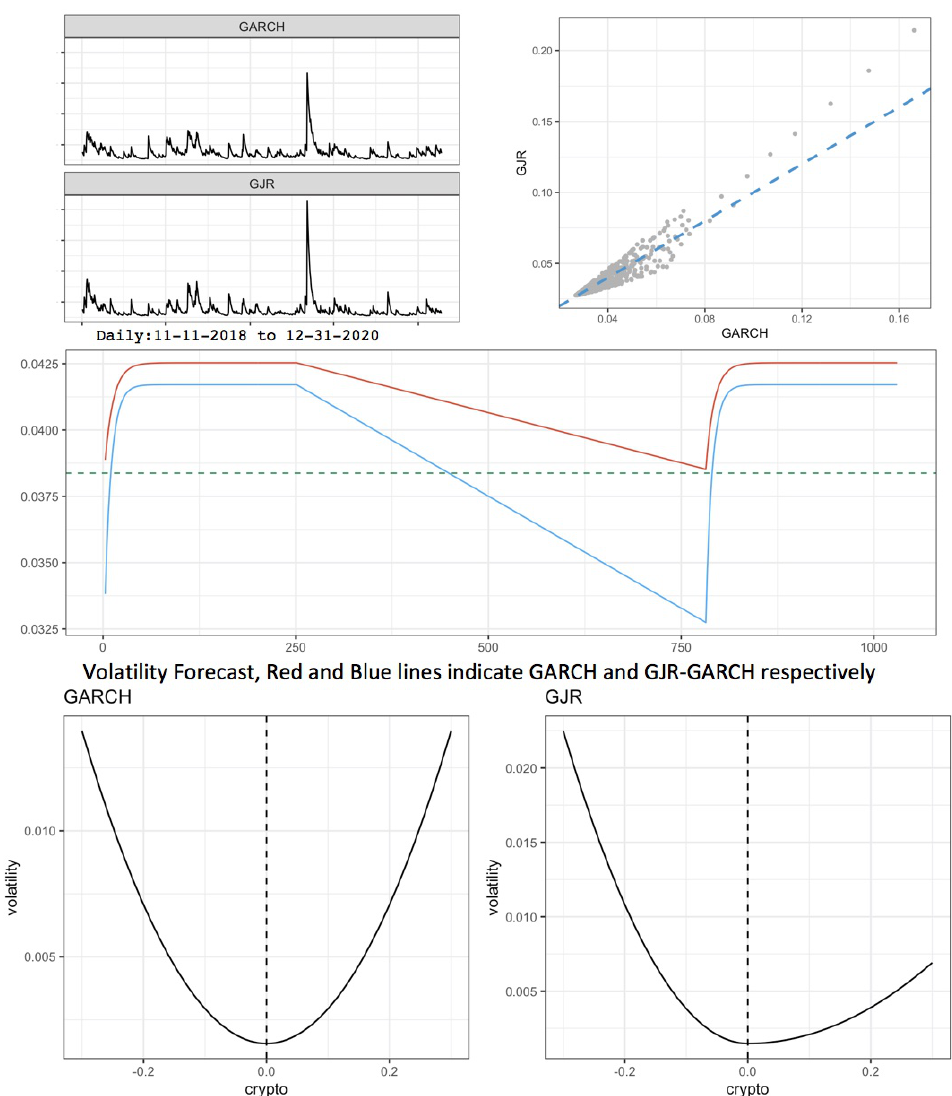
Figure 5. Comparison between GARCH(p,q) and GJR-GARCH(p,q) models. In Figure 6, we forecast the volatility for the ten cryptocurrencies. It shows daily data where the blue line indicates predicted volatility. If we examine the historical return series, it does not show conditional mean offset and thus exhibits volatility